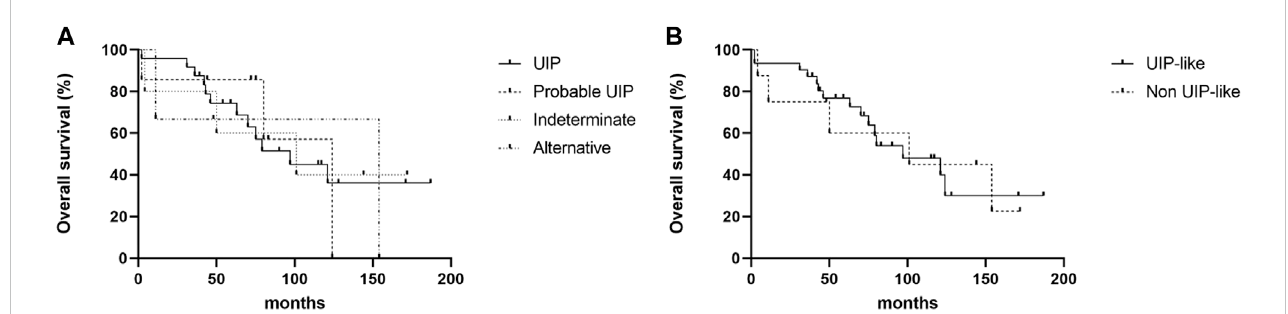
FIGURE 2 Kaplan — Meier survival curve of patients with MPA-ILD according to HRCT patterns. (A) Comparison of overall survival according to the HRCT patterns, (B) Comparison of overall survival between patients with UIP-like pattern and non-UIP-like pattern. (A) There were no differences in overall survival rates according to the HRCT patterns; the median survival period was 97.0 months for a UIP pattern, 124.0 months for probable UIP, 101.0 months for indeterminate UIP, and 154.0 months for alternative diagnosis (log-rank test, p = 0.985). (B) There was no difference in the overall survival between patientswithUIP-likeandnon-UIP-likepatternonHRCT;themediansurvivalperiodwas97.0 monthsforUIP-likepattern,and101.0 monthsfornon-UIP-like pattern (log-rank test, p = 0.969). MPA, microscopic polyangiitis; ILD, interstitial lung disease; HRCT, high resolution computed tomography; UIP, usual interstitial pneumonia.